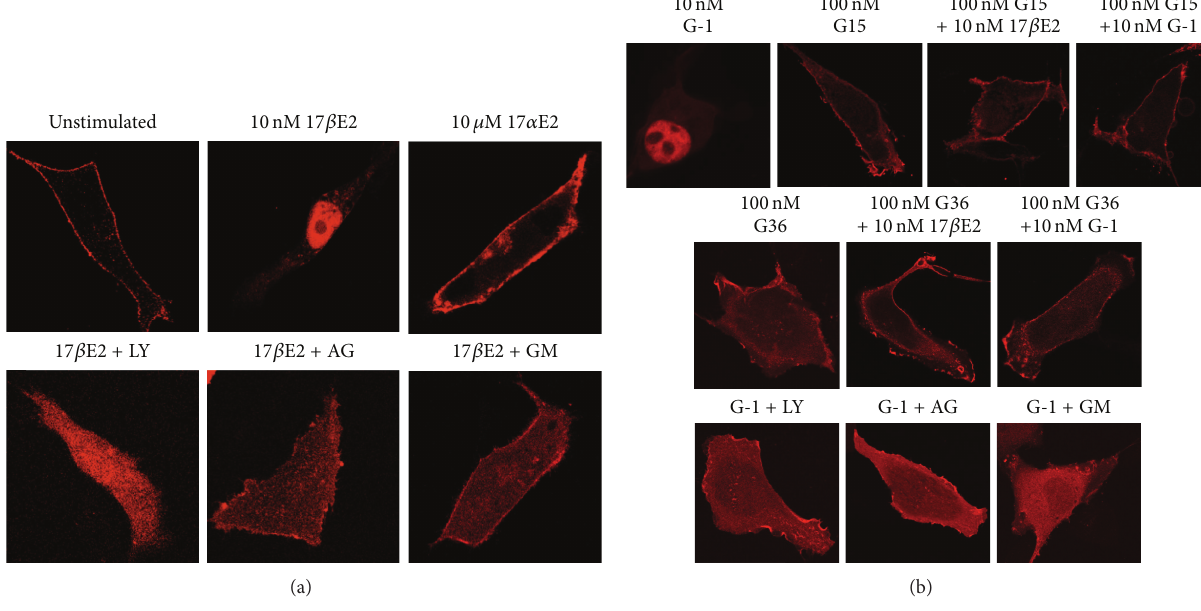
Figure 3: Activation of PI3K by estrogen in Hec50 cells is mediated by GPER. Hec50 cells were transfected with a marker of PIP3 production, the PH domain of Akt fused to monomeric red fluorescent protein (mRFP) yielding the marker PH-RFP. (a) PH-RFP-transfected Hec50 cells werestimulatedwiththefollowingligands:10 nMestrogen(17 𝛽 E2),10 𝜇 M17 𝛼 -estrogen(17 𝛼 E2),or10nMestrogeninthepresenceofthePI3K inhibitor LY294001 (10 𝜇 M, 20 min pre-incubation; 17 𝛽 E2 + LY), the EGFR inhibitor AG1478 (25 𝜇 M, 60min pre-incubation; 17 𝛽 E2 + AG)